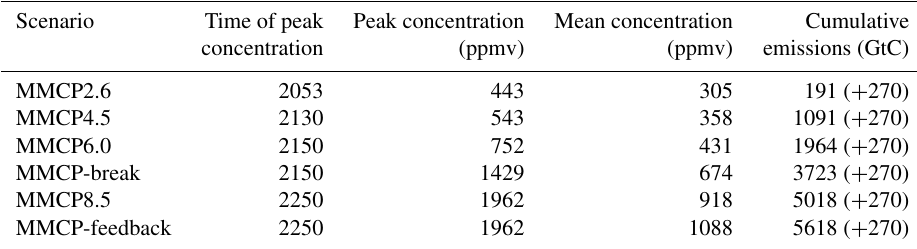
Table A3. Different CO 2 scenarios used in the simulations with their time of peak concentration, the values for the peak concentration, the mean concentration over the next 10000 years, and the equivalent total emissions (calculated as in Meinshausen et al., 2011). The total cumulative emissions are an approximation for the RCP scenarios (the numbers give the total fossil fuel cumulative CO 2 emissions expressed in gigatonnes of Carbon for the period 2000–2300CE). These numbers are on top of the cumulative CO 2 emissions before 2000CE given in brackets (about 270GtC; Ciais et al.,